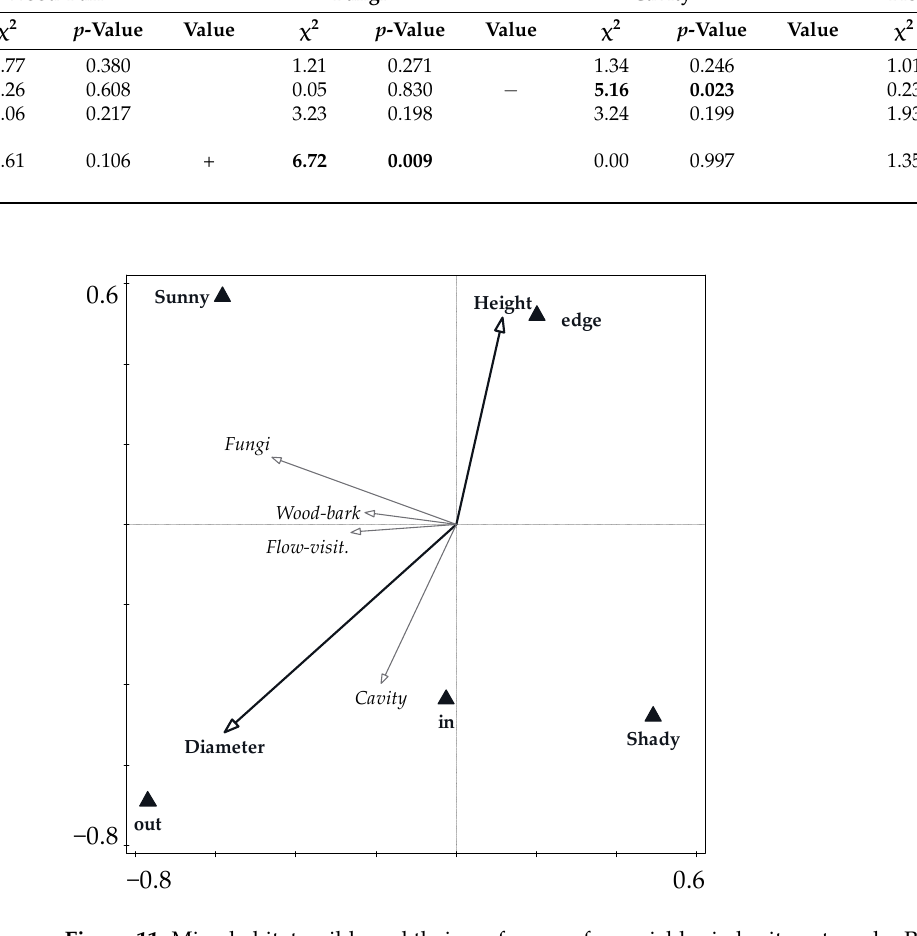
Table 2. Species guild richness of saproxylic beetles in the study location (log χ 2 linear model, Poisson distribution). Value (+) corresponded to positive response of variable and ( − ) negative response. Statistically significant effects are marked in bold.